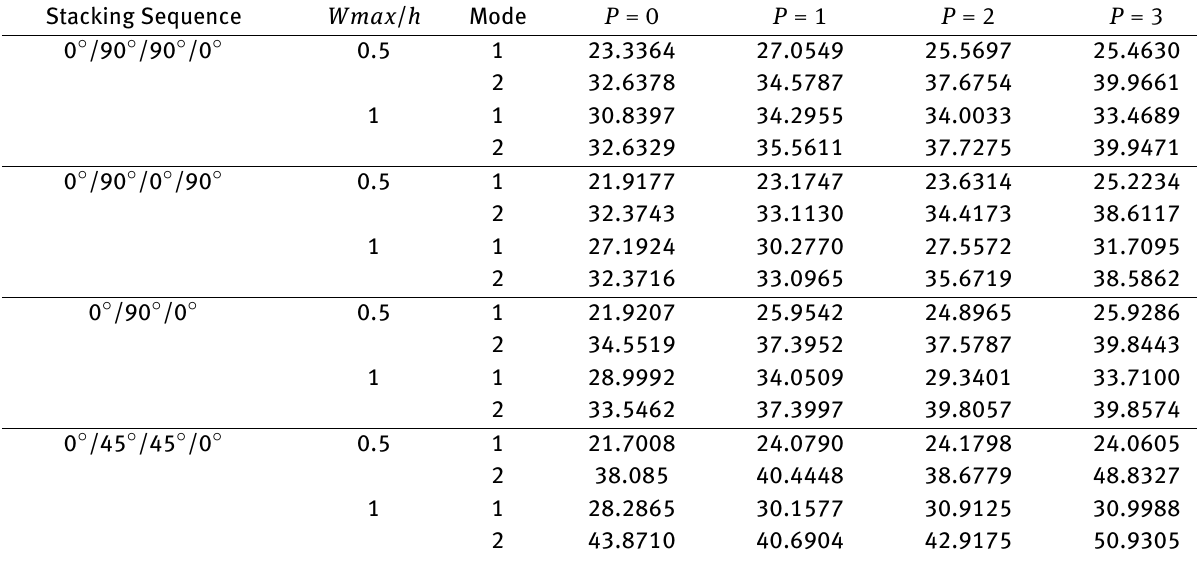
Table 7: Effect of lamination scheme, amplitude ratio and frequency mode with position of piezoelectric layer on the dimensionless mean nonlinear natural frequency of conical shell